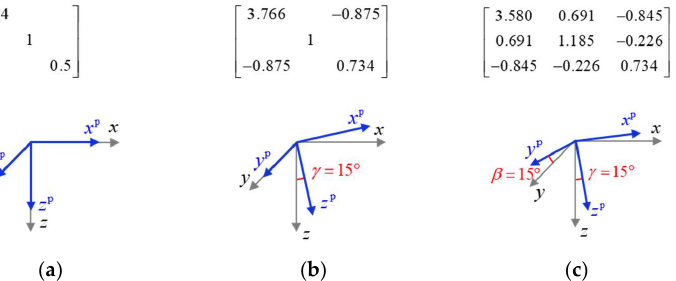
Figure 12. Three specific BA conductivities and the orientations of the principal coordinates x p y p z p with respect to the formation coordinates xyz , where β and γ are the anisotropic azimuthal and dip angles (similar to the definition of α and θ in Figure 7b), respectively. ( a ) Simple BA. ( b ) Dipping BA. ( c ) Full-tensor BA.